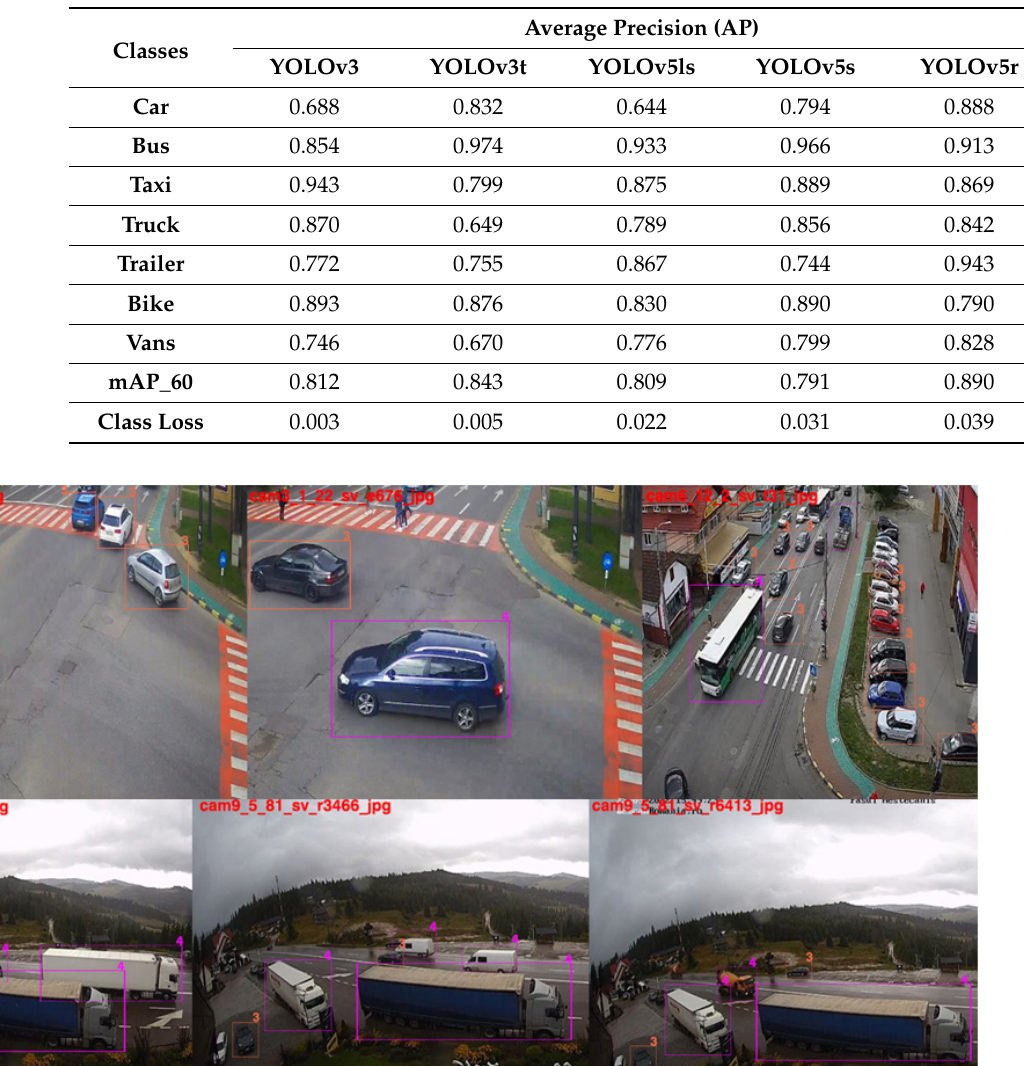
Table 4. Performance of YOLO networks for SR1 training sets and their evaluation and validation.